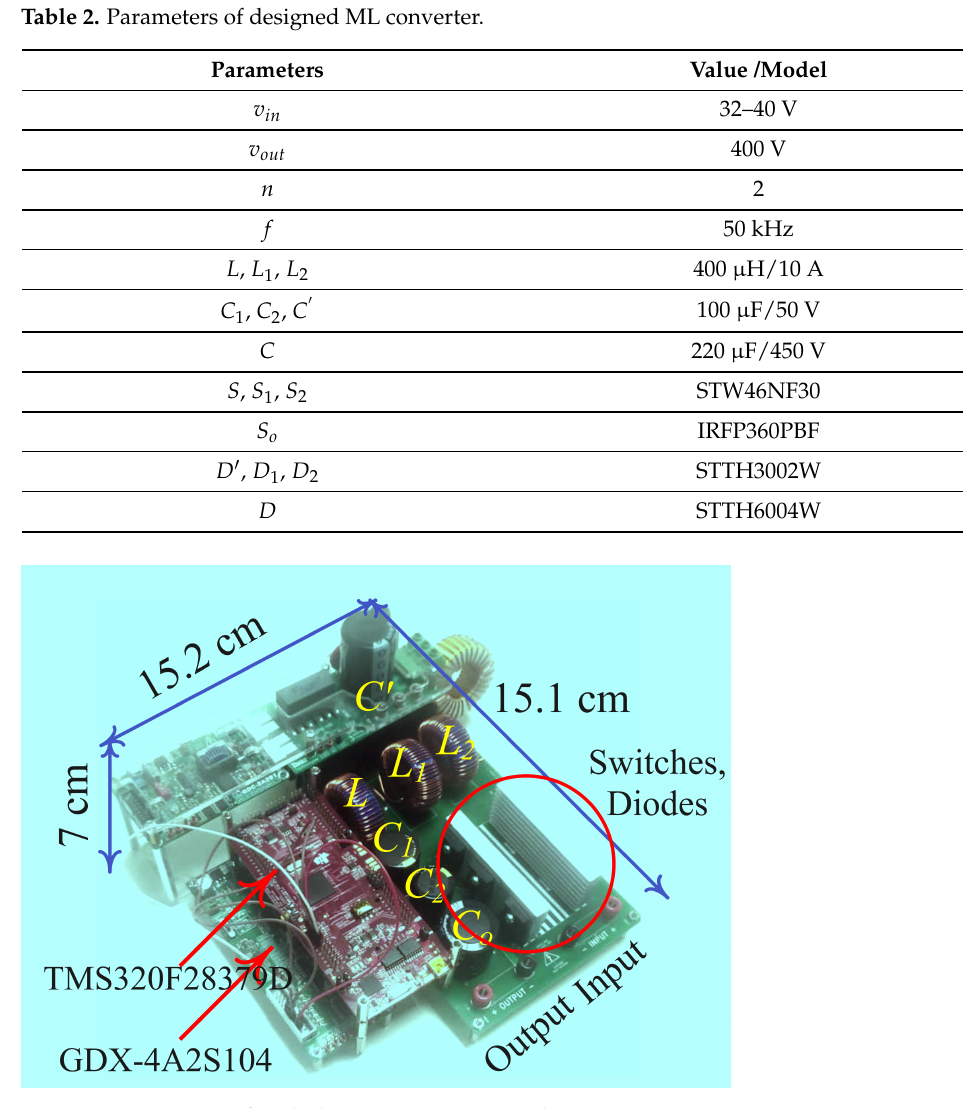
Figure 15. Prototype of multi-leg (ML) converter with n =